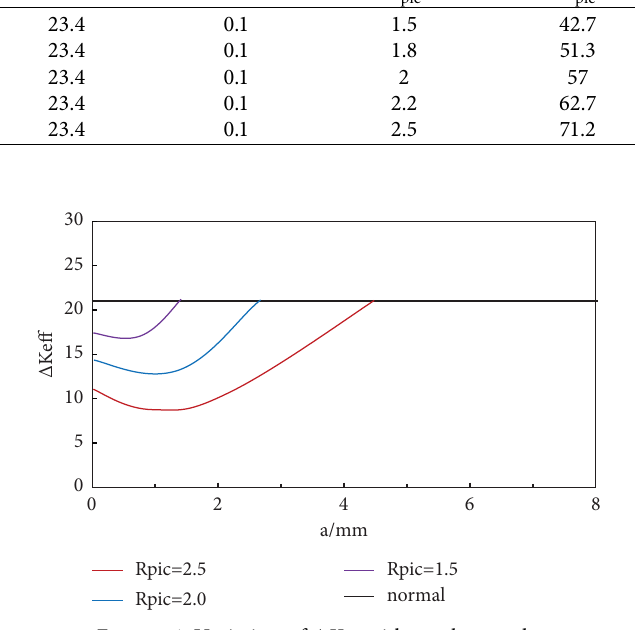
Figure 6: Variation of Δ K